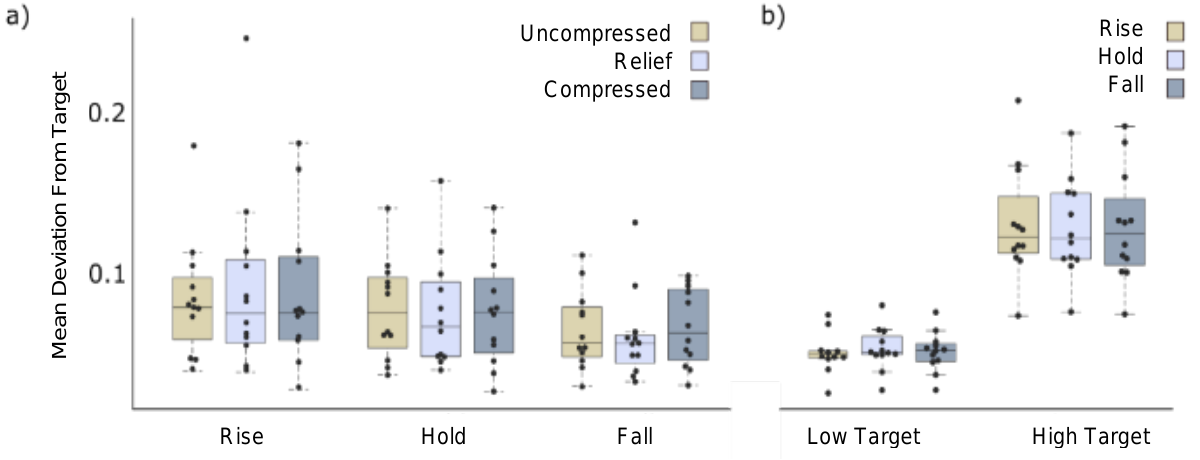
Figure 4: Results from the myoelectric target tracking control tasks. Mean absolute deviation from the target for (a) the rise, hold and fall periods for all trials (b) low targets and high targets. In all box plots, the upper and lower box boundaries represent the respective upper and lower quartiles, the whiskers represent the maximum and minimum excluding outliers, and the centre line represents the median.